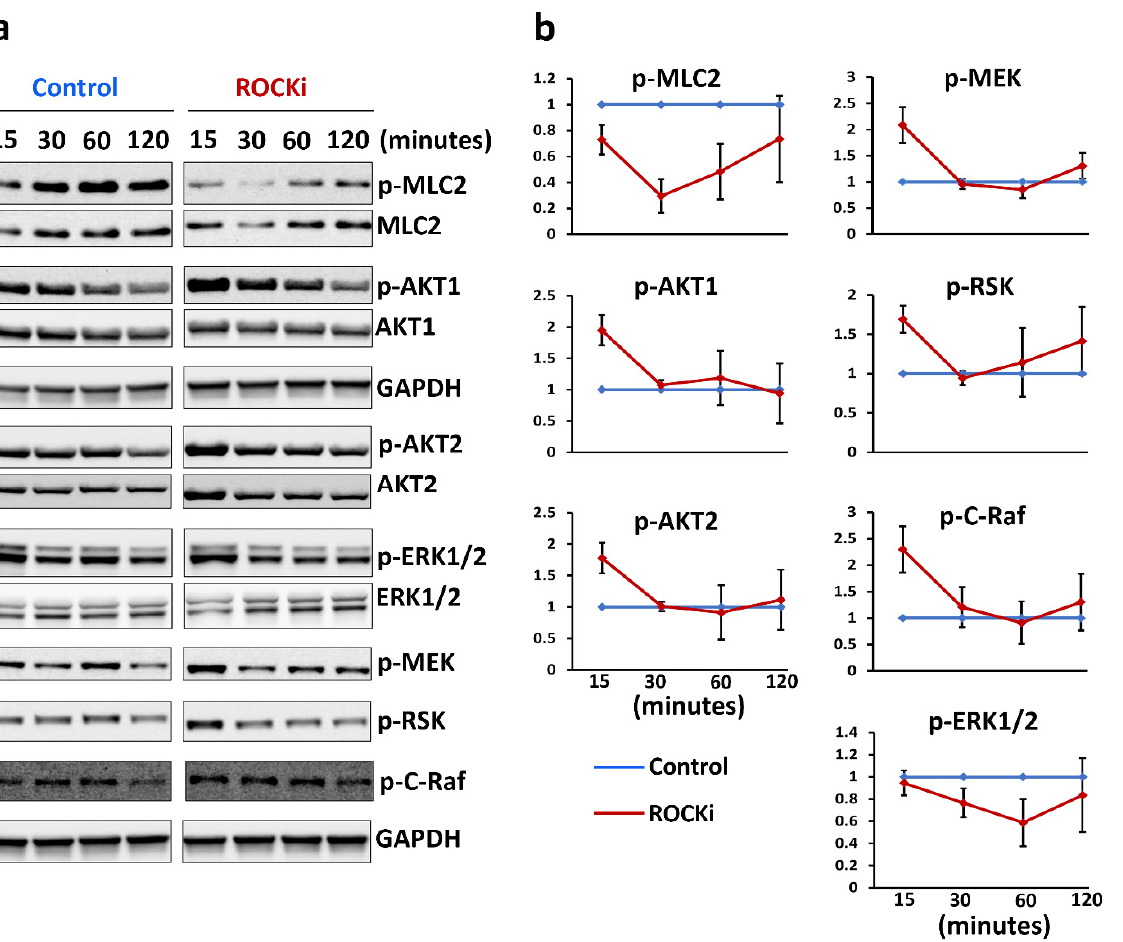
Figure 8. ROCKi-activated AKT and MAPK signalling. Representative immunoblot images show the changes in phosphorylation of kinases involved in AKT and MAPK signalling in cells treated with ROCKi at different time points ( a ). GAPDH was used as a loading control. Densitometry quantification of immunoblot at different time points ( b ). Data were normalized to GAPDH and are presented as mean ± S.D., n = 3.